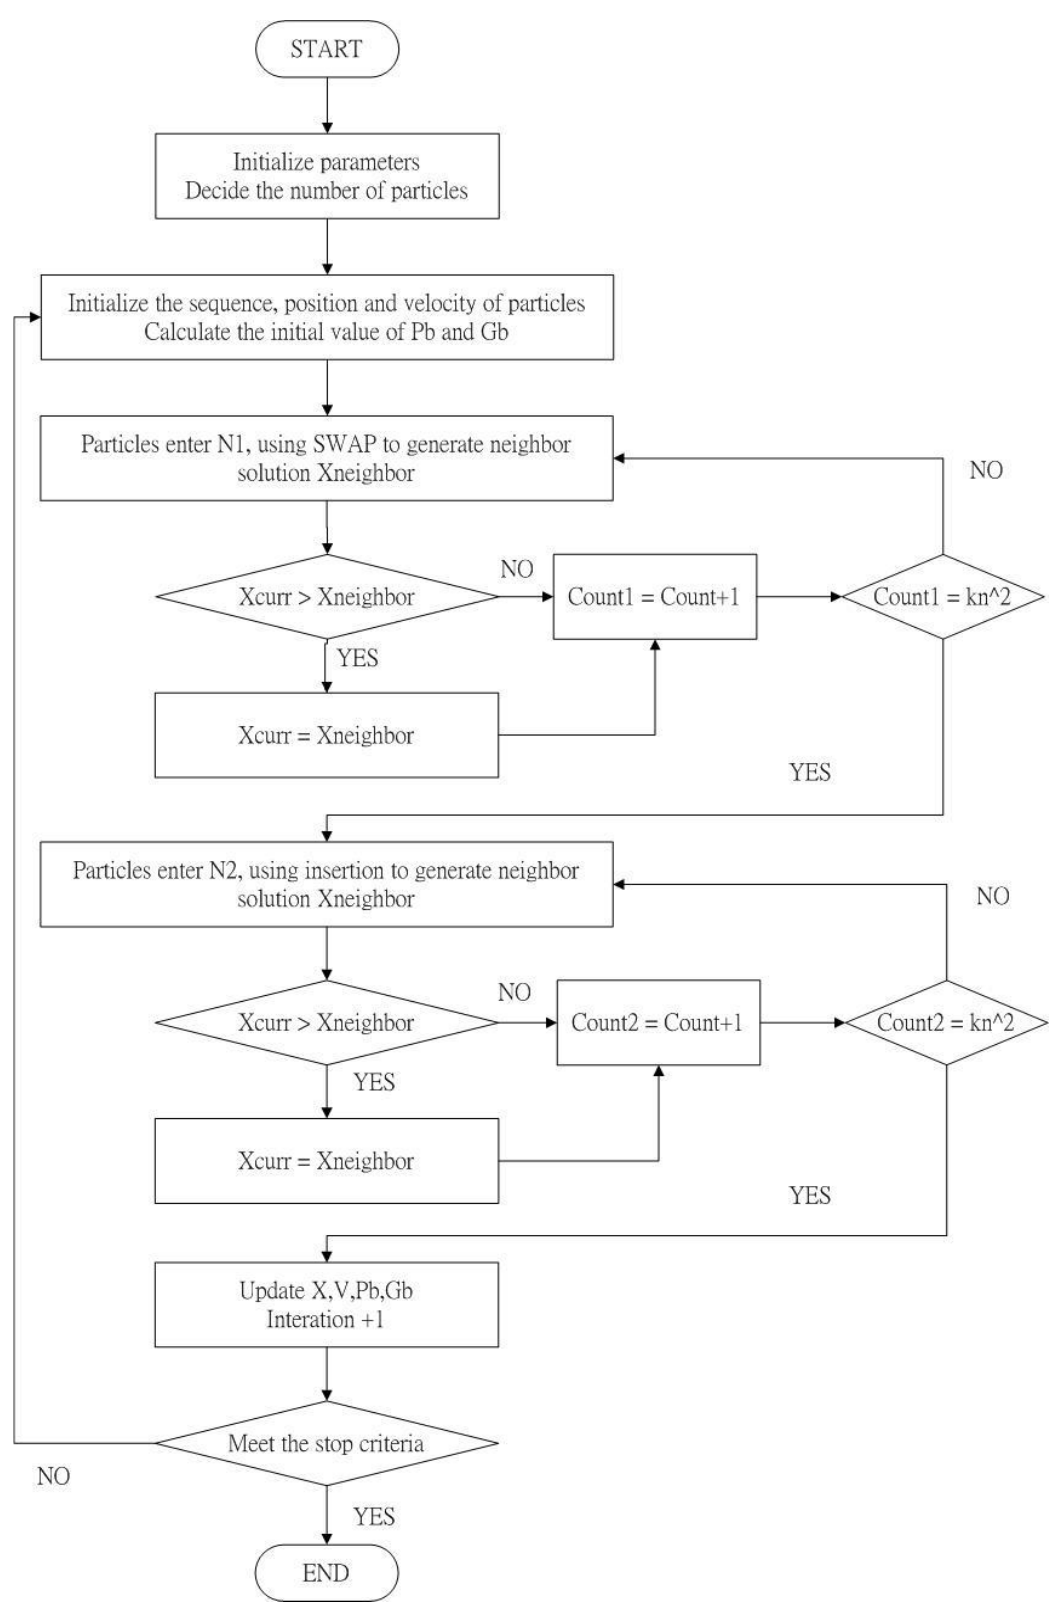
Figure 5. PSO + VNS.